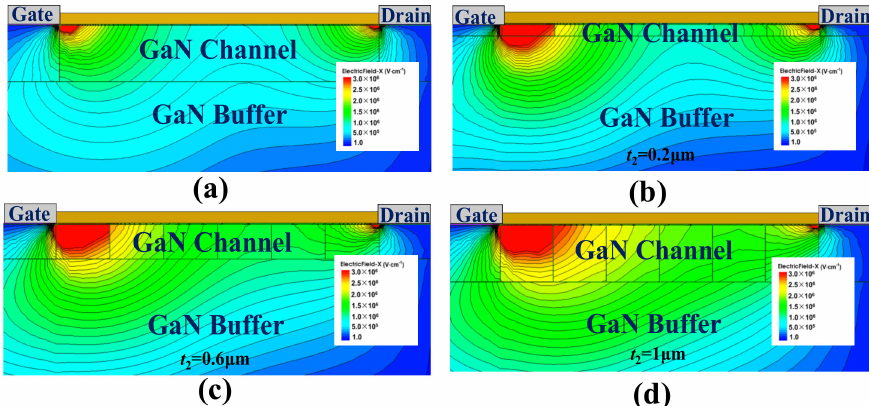
Figure 10. The 2–D E–field distributions of ( a ) the conventional HEMT and ( b – d ) the SDC–HEMTs with different channel